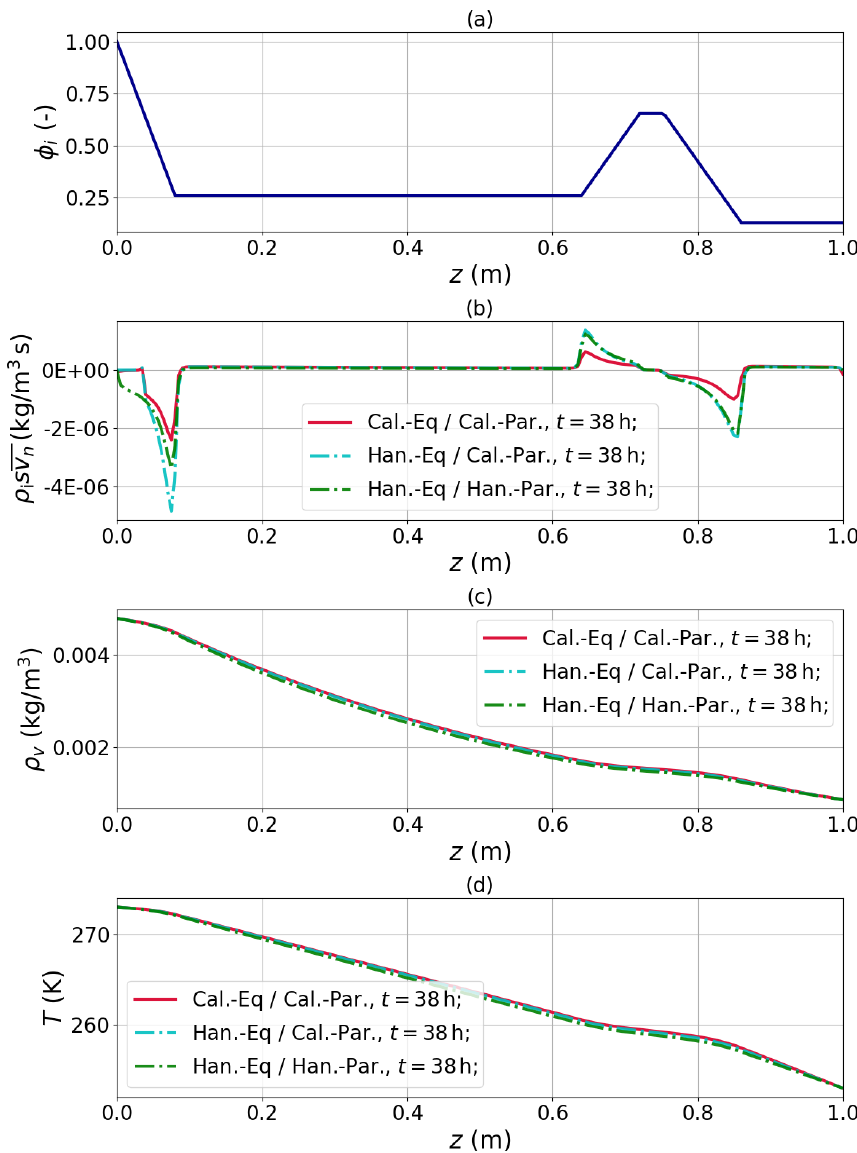
Figure 2. Comparison of Calonne’s and Hansen’s model for the response to a piecewise-linear, layered profile under a temperature gradient without ice-phase evolution: the results for Hansen’s model are indistinguishable even if different PDE coefficients are used (green and turquoise lines) but differ from the Calonne model (red